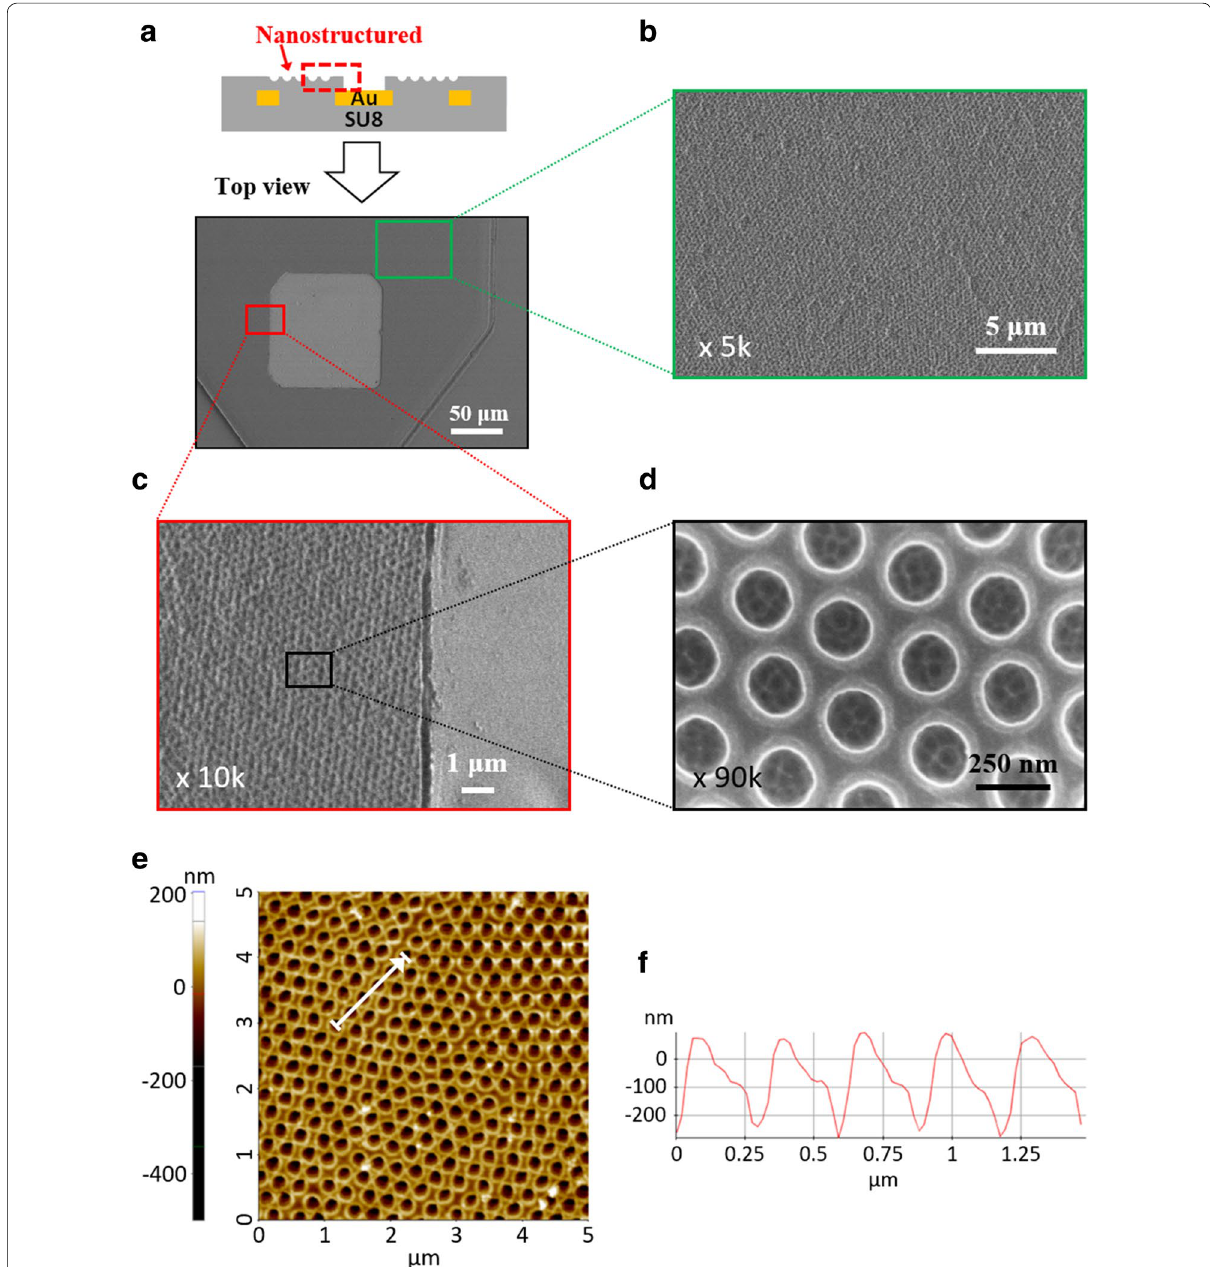
Fig. 4 Nanostructured area of a microprobe. a Schematic of a nanostructured area on the microprobe surface, and SEM image of the top of a microprobe showing a gold electrode. SEM images of the boxed areas in ( a ); b nanostructured area; c boundary between a nanostructured area and a gold electrode; d enlargement of the boxed area in ( c ); e AFM image (5 5 μm) of a nanostructured microprobe surface; and f line profile of × the white arrow in ( e ). Nano‑holes are ~ 200 nm in both diameter and